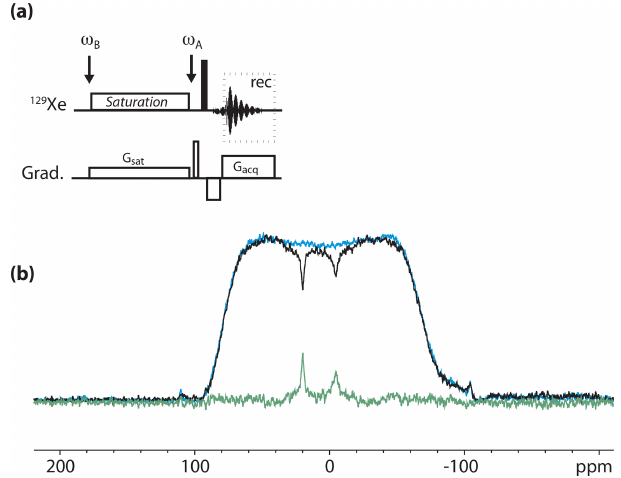
Figure 4. (a) Pulse sequence used for the 129 Xe UFZ spectroscopy. ω B and ω A denote the rf offset placed in the region of caged xenon and at the frequency of free xenon, respectively. (b) 129 Xe UFZ spectrum of the noble gas into the solution containing the crypto- phane mixture at 11.7T and 295K. In black: the profile obtained after 2s saturation at a field strength B 1 = ω 1 /γ = 7µT ( on exper- iment); in blue: same profile without saturation ( off experiment); in green: off–on . Other important parameters: G sat = 35mTm − 1 ; G acq = 90mTm − 1 .